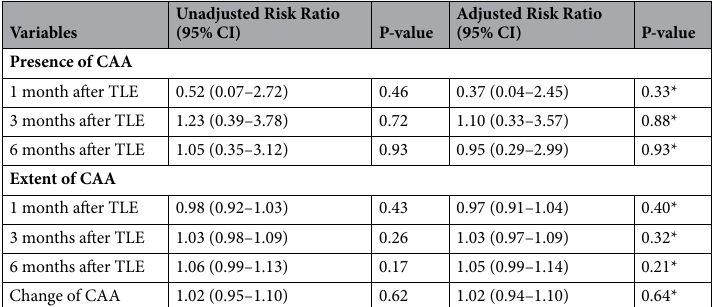
Table 2. Association between surgical success and complete avascular area (CAA). *Multivariable analysis is performed with surgical success as the objective variable, in which each of the items related to CAA (presence, extent, and change) is adjusted for age, operation method, and preoperative